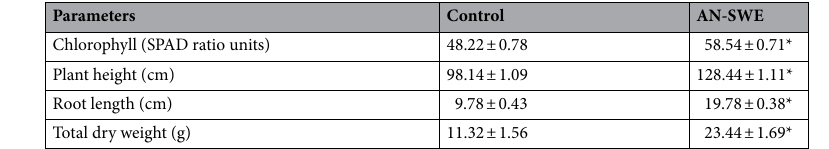
Table 1. Effects of AN-SWE on important plant growth parameters in tomato. The data represents the average measurements from 30 randomly selected plants ± SD. The data were analysed for significant differences by Student’s t-test and significances represented by an